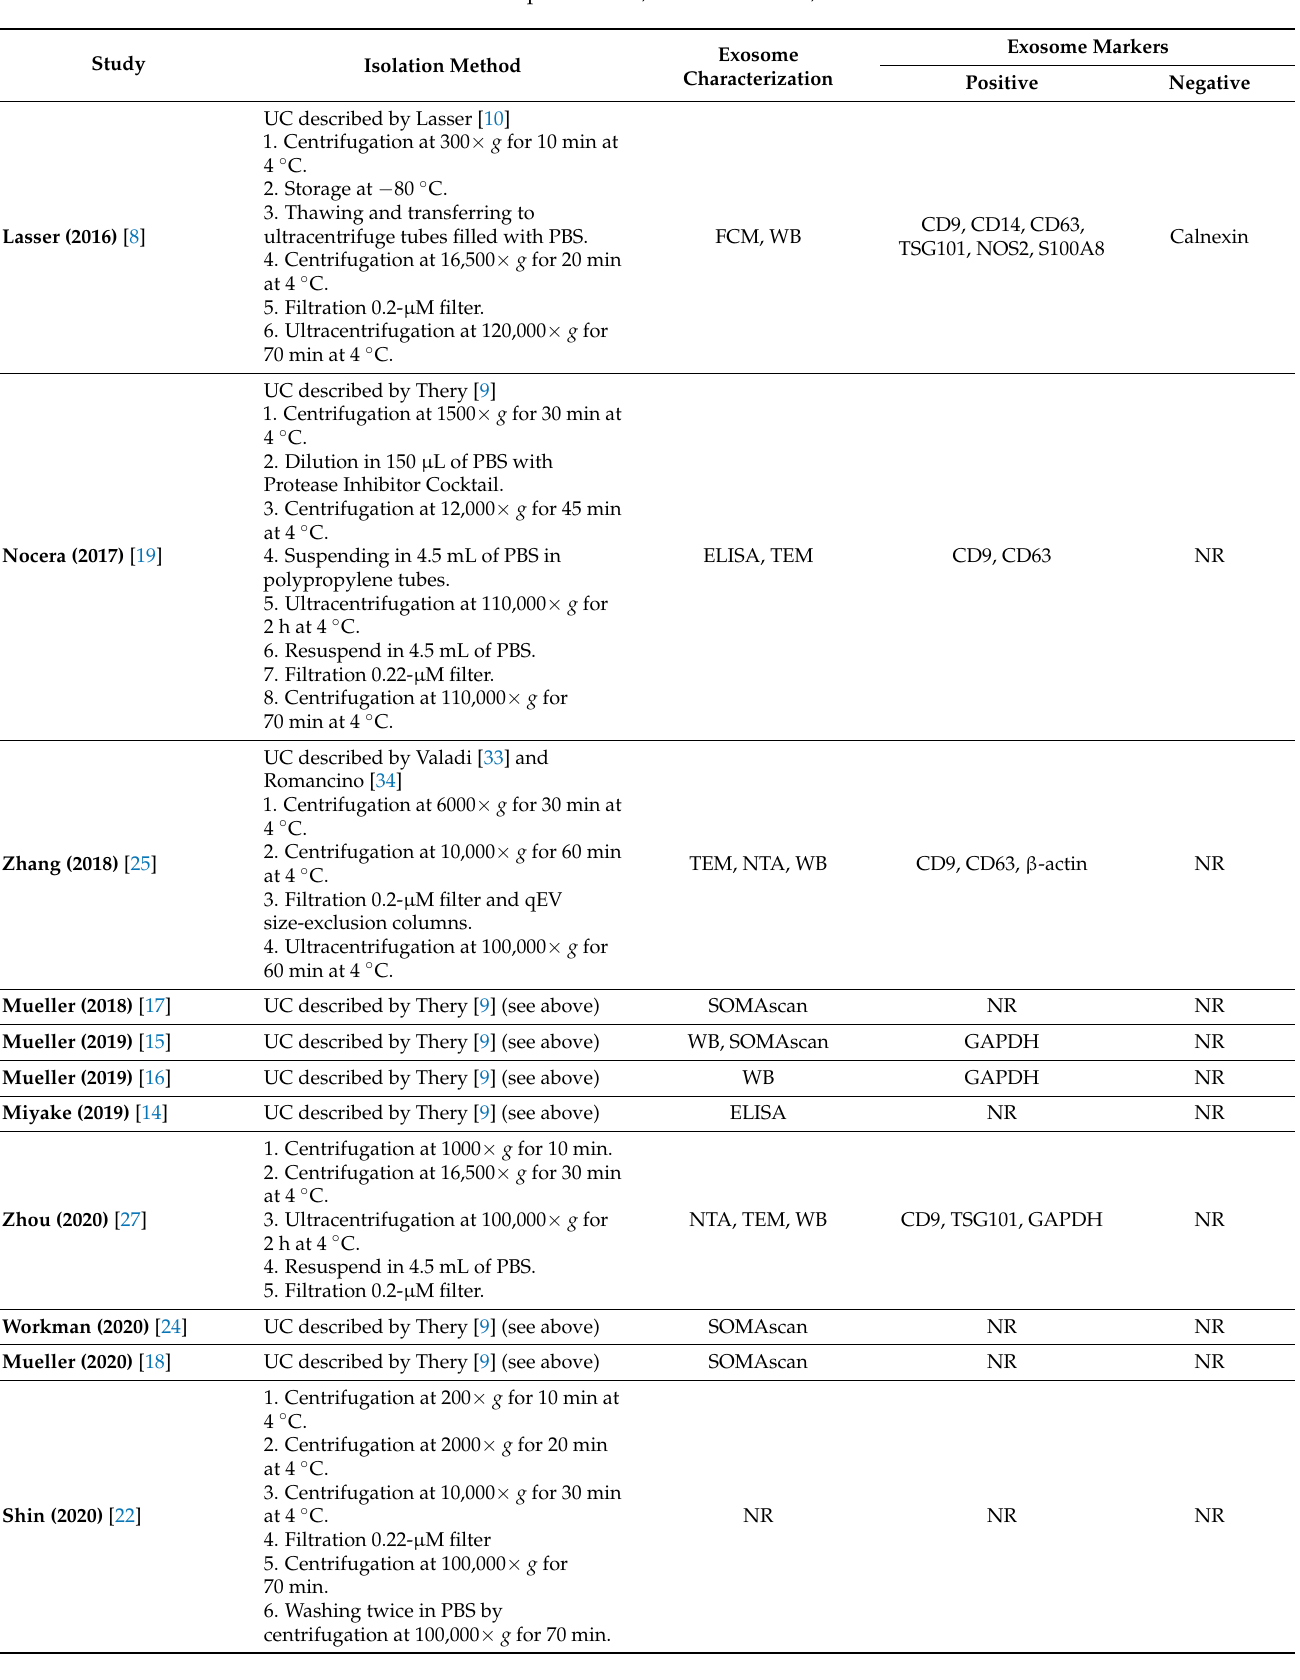
Table 3. Overview of purification, characterization, and exosomal markers used in included